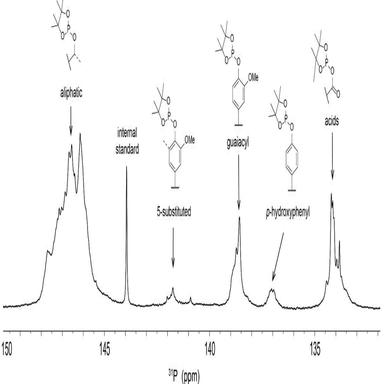
31P NMR analysis of the lignin PSS1 isolated after pilot scale soda pulping of Miscanthus x giganteus.